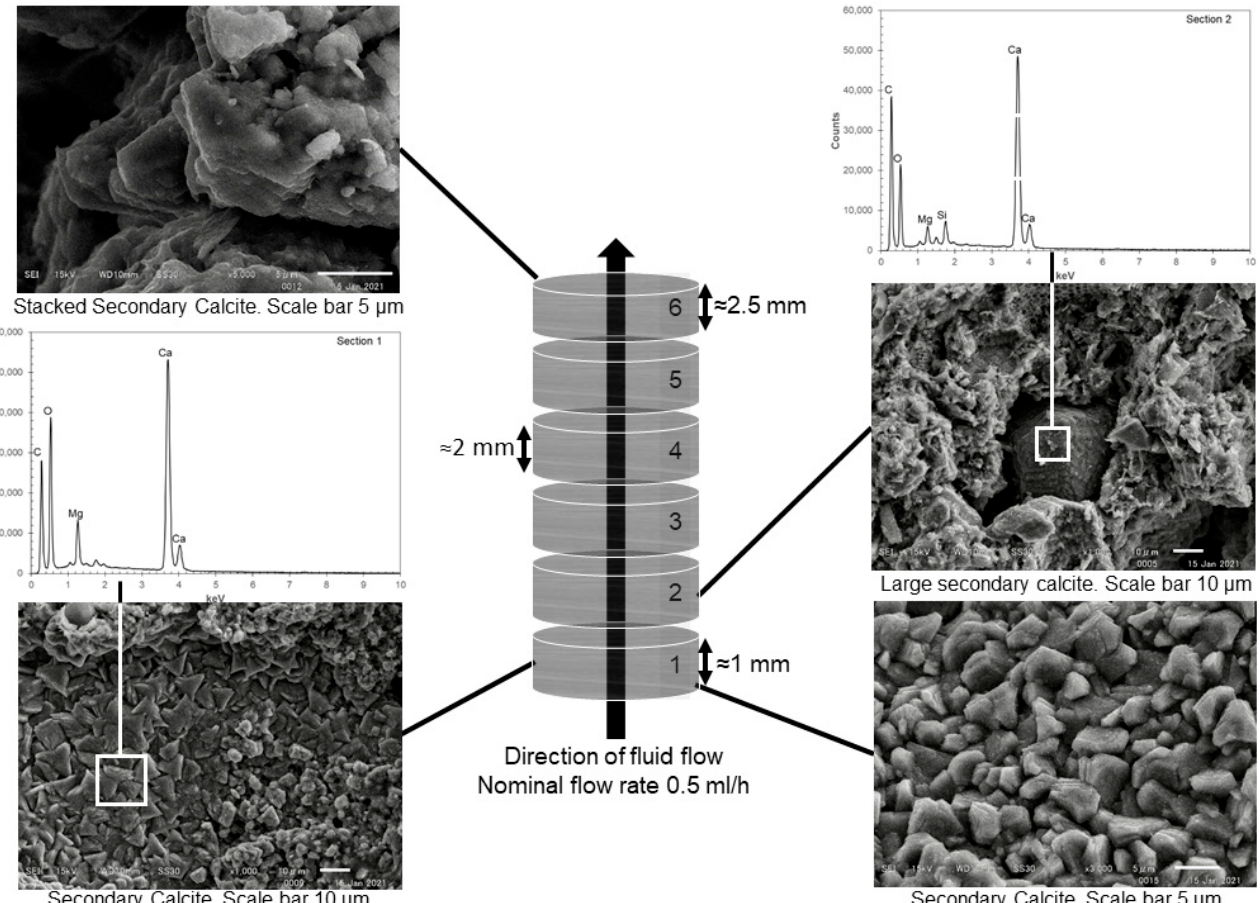
Figure 7. Summary of mineralogy of Horonobe mudstone with ‘young’ OPC (Na-K-Ca-OH), then ‘evolved OPC leachate (Ca(OH) 2 ), and then HGW (SFC-3). Except where indicated, each section was ~1.5 mm. All SEM photos are secondary electron (SE) images. The white square in the SEM images from sections 1 and 2 indicate the areas used for SEM-EDS analysis of the secondary carbonates.